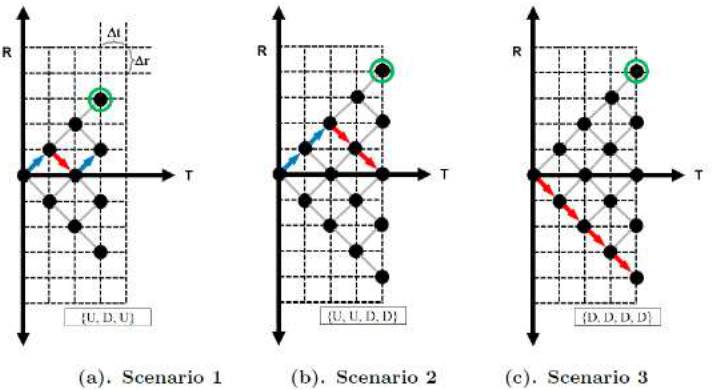
Figure 1. Three discrete random walks in